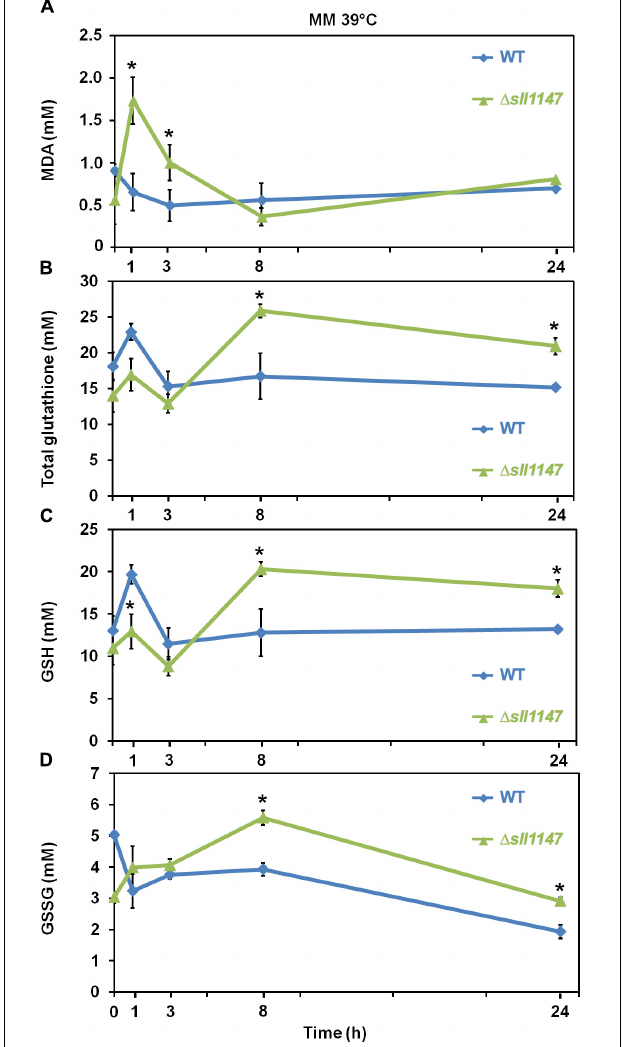
FIGURE 5 | The (cid:49) sll1147 heat sensitive mutant challenged by heat transiently accumulates peroxidized lipids, GSH, and GSSG. Kinetic analysis of the influence of high temperature exposure (39 ◦ C) on the abundance of peroxidized lipids measured as MDA content (A) , total glutathione (B) , GSH (C) , and GSSG (D) in Synechocystis WT and mutant (cid:49) sll1147 . Data are expressed as the mean ± SD of three assays and ∗ indicates significant difference between mutant and WT ( t -test, P <